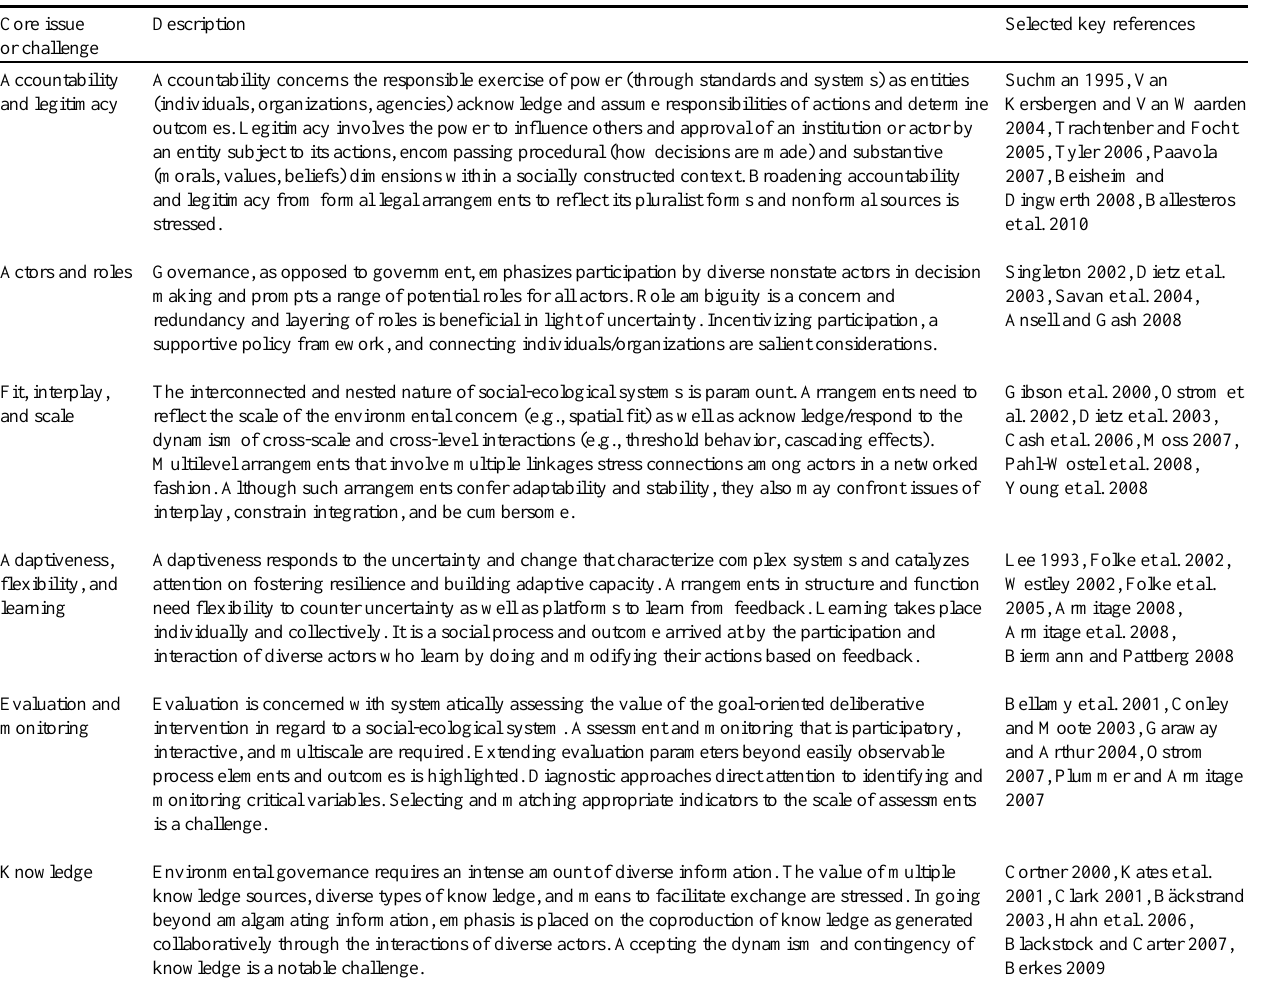
Table 1 . Core environmental governance issues or challenges (adapted from Armitage et al.